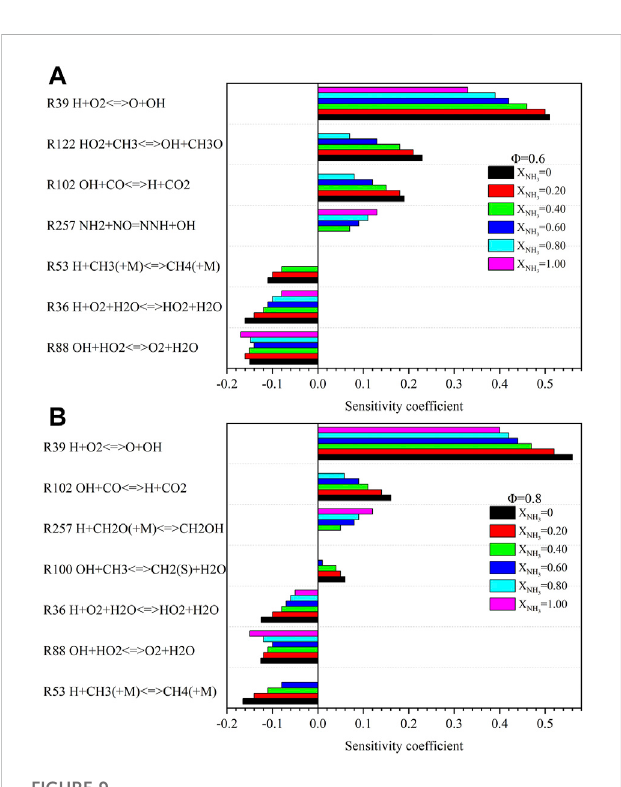
FIGURE 9 Sensitivity analysis of temperature with different ammonia content: (A) Φ = .6; (B) Φ = .8. (T = 723 K, p = 16.5